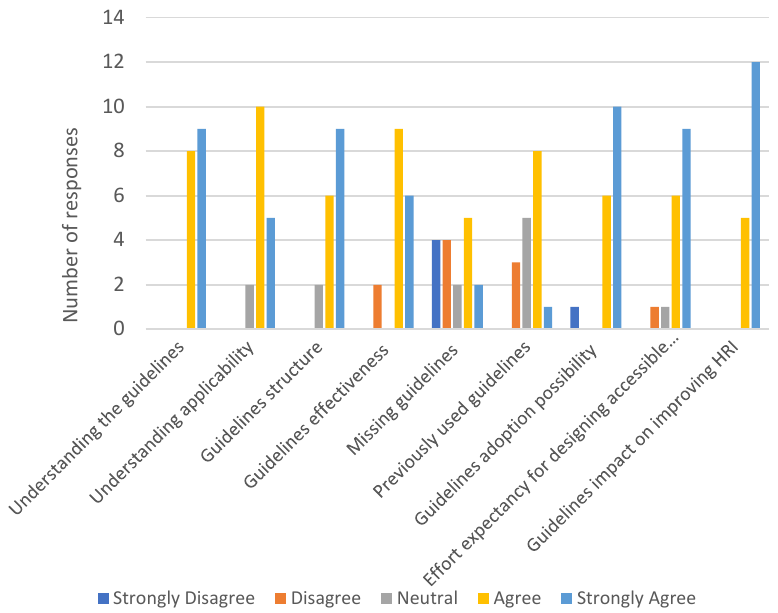
Figure 3. Number of responses assigned to scale point for each question.